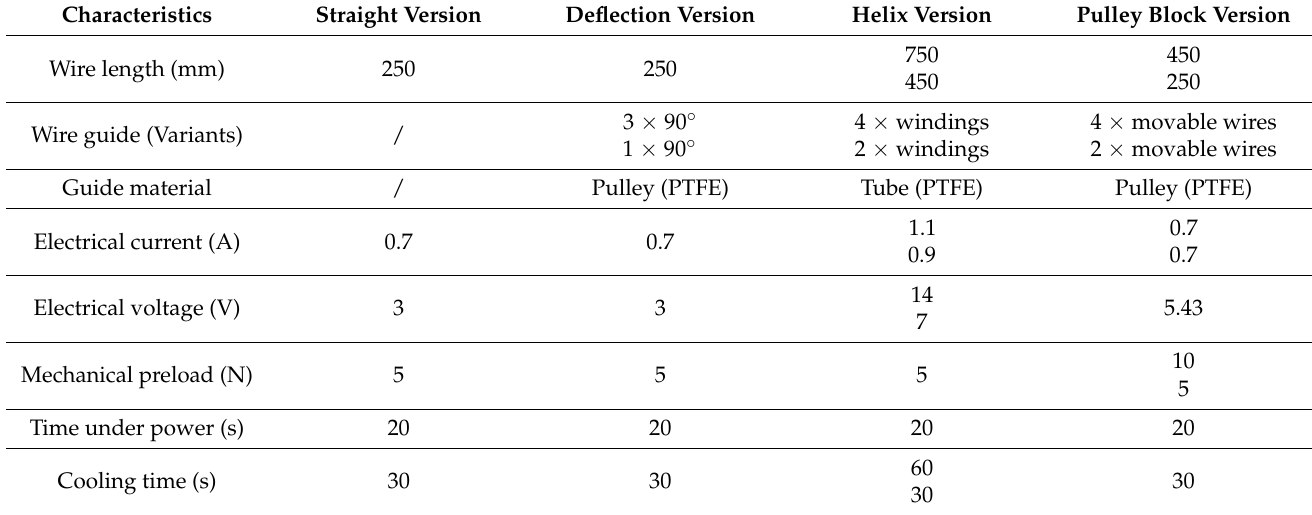
Figure 7. Different deflection variants in the sketch are shown in the top row and the final manufac- tured joint assemblies in the bottom row. ( a ) Straight clamped SMA wire for reference measurement; ( b ) deflection variant using PTFE pulleys with 3 × 90° and 1 × 90° deflection; ( c ) helix deflection in PTFE tube with long helix and short helix and ( d ) pulley block with PTFE pulleys with big pulley and small pulley. Table 3. Description of the deflection versions and variants installed in the test rig. If there are several values per line, the values of the following line always refer to the order of the previous ones. If only one value is listed below, it applies to both previous values.